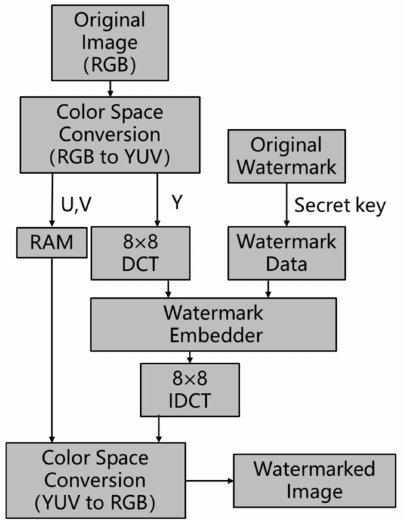
Figure 1. Traditional DCT-based watermarking